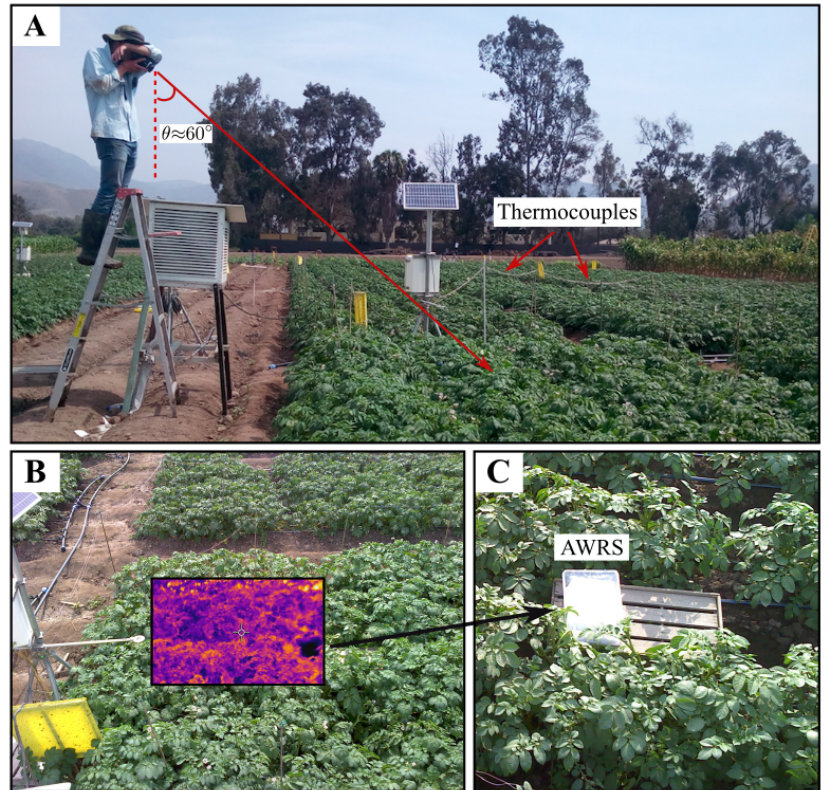
Figure 1. Acquisition procedure of infrared thermography (IRT) and red-green-blue (RGB) images using the FLIR E60 model thermal camera, according to the procedure of Rinza et al. [8] ( A ). The IRT and RGB images acquired in A ( B ). AWRS—the artificial wet reference surface ( C